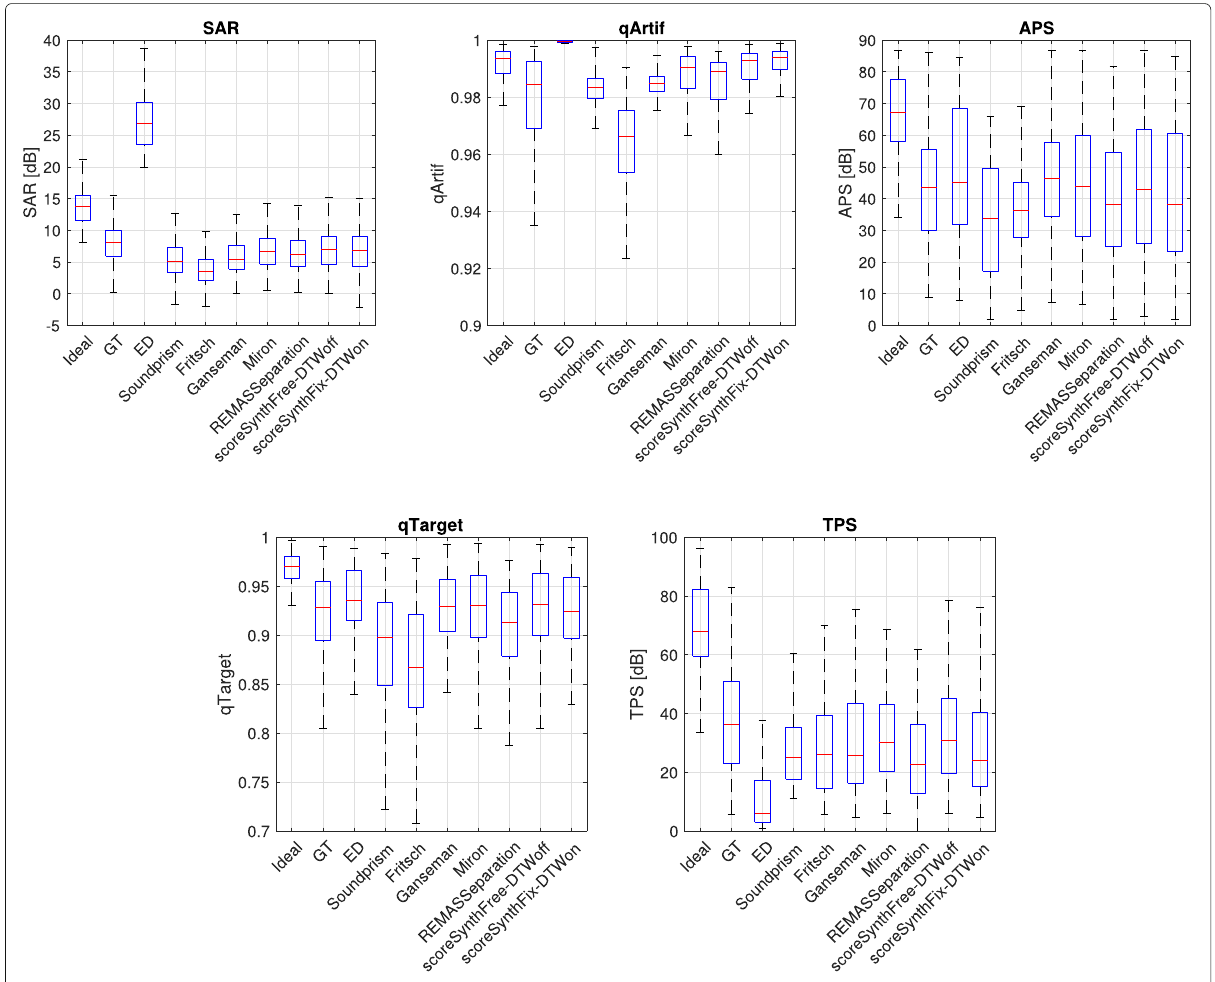
Fig. 13 Additional objective and perceptual measures for Fig.